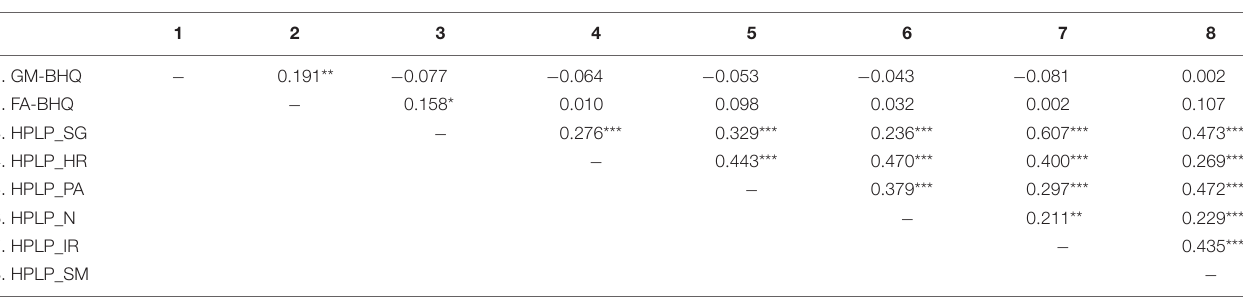
TABLE 3 | Partial correlation matrix controlling for sex a , age, and